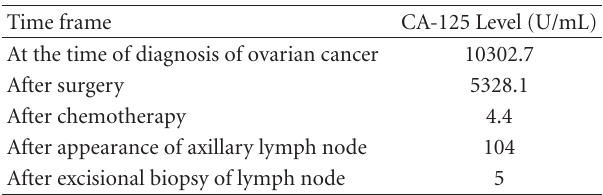
Figure 2: Axillary lymph node metastasis from ovary. Table 1: CA-125 level trend in the patient.